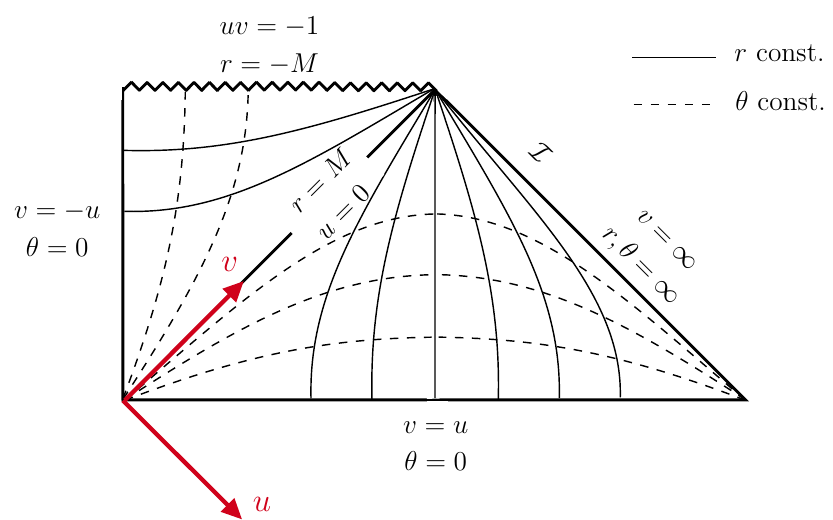
Figure 2. The toric Penrose diagram for Kleinian M = N Taub-NUT. There is a horizon at u = 0 , and a singularity at uv = − 1 , corresponding to r = − M . Lines of constant r are solid, and lines of constant θ are dashed. Null infinity, I , and the horizon r = M are labelled. The timelike cycle of the torus degenerates along the spacelike line v = u , while the spacelike cycle degenerates along the timelike v = − u